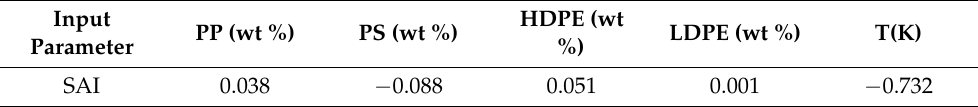
Table 8. Relative importance of the input parameters.